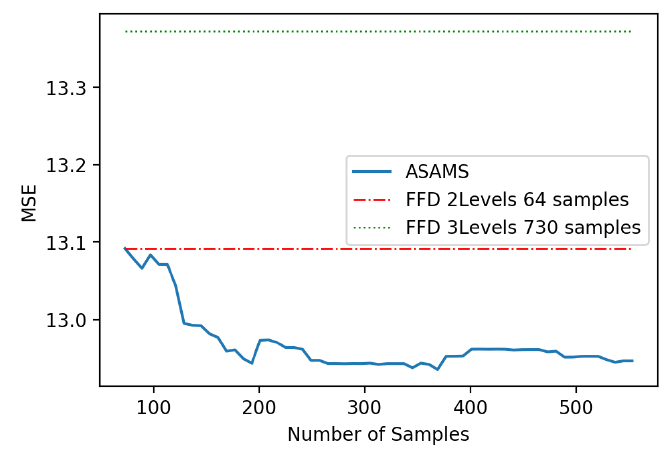
Figure 11. Interest region squared mean error (MSE) comparison of a nonlinear oscillator.